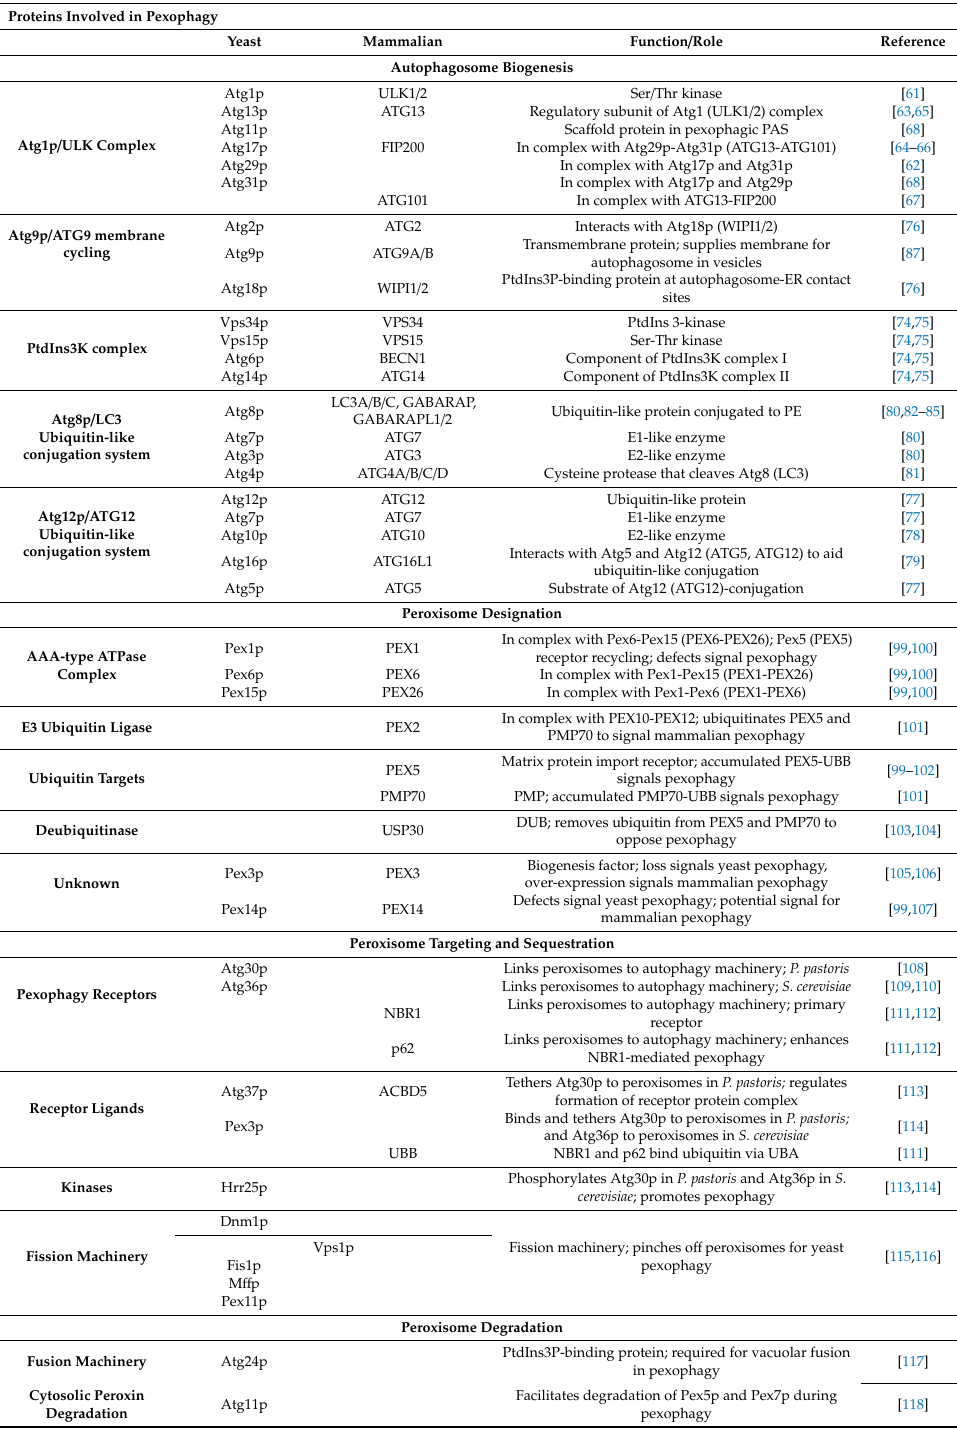
Table 1. Proteins involved in pexophagy. Table 1 was prepared to reflect the steps of pexophagy: autophagosome biogenesis, peroxisome designation, targeting and sequestration and degradation (as illustrated in Figure 2). The autophagosome biogenesis genes were adapted from Reference [64]. The pexophagy factors were manually curated from literature. Here, slash nomenclature denotes isoforms while commas denote subfamilies. Yeast proteins are named followed by the mammalian protein homologue in brackets in the ‘Function / Role’ column, when